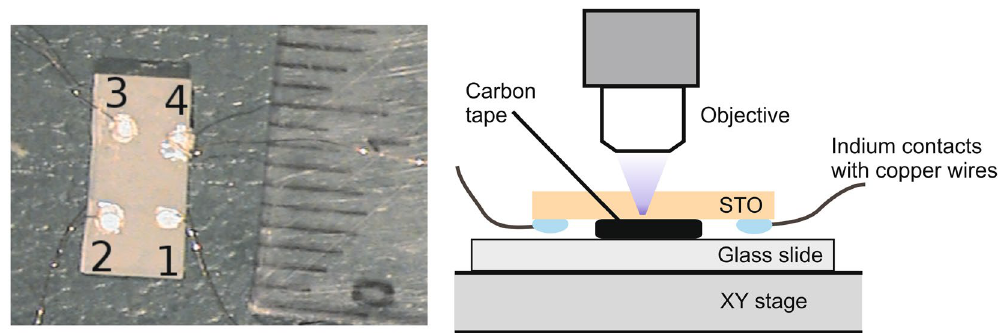
Figure 6. Left: Photograph of STO crystal with contacts used for the photo-lithography experiment. Contacts are labeled 1–4. A ruler is next to the crystal for scale; each black line is 1 mm. Right: Schematic diagram of the experiment.